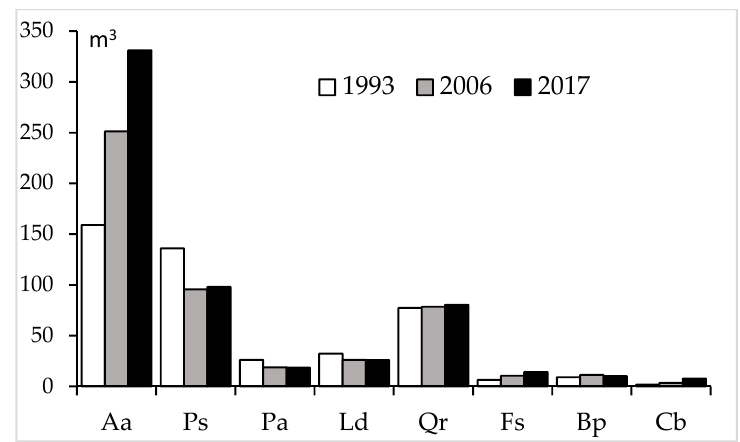
Figure 4. Changes in growing stock (V, m 3 ) over the investigated period by tree species present in the multispecies, uneven-aged forest located in the Unieszów Forestry Range.